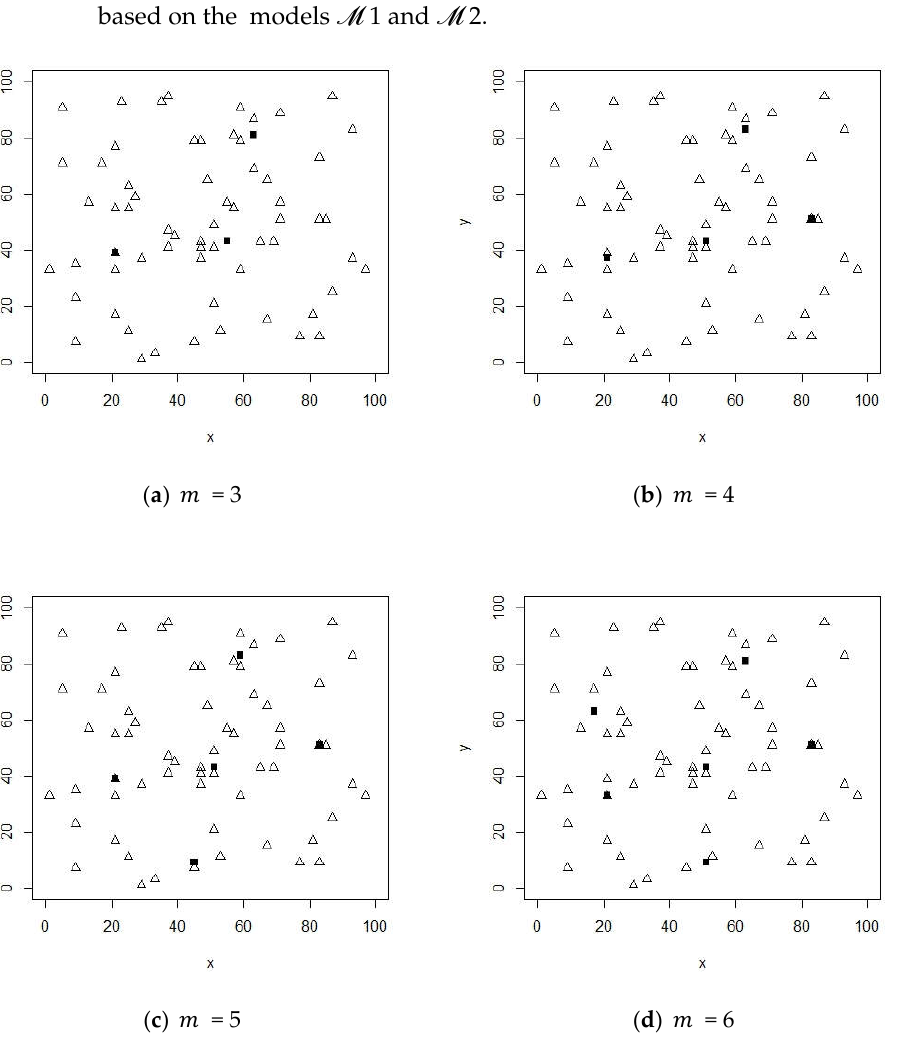
Figure 3. Globally optimal facility locations in the planning area for Instance 24. ( a ) m = 3; ( b ) m = 4; ( c ) m = 5; ( d ) m = 6.